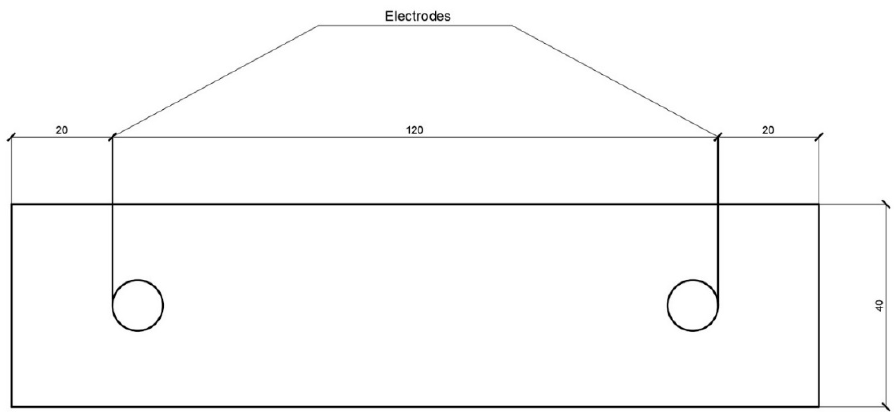
Figure 1. Electrical conductivity measuring diagram.